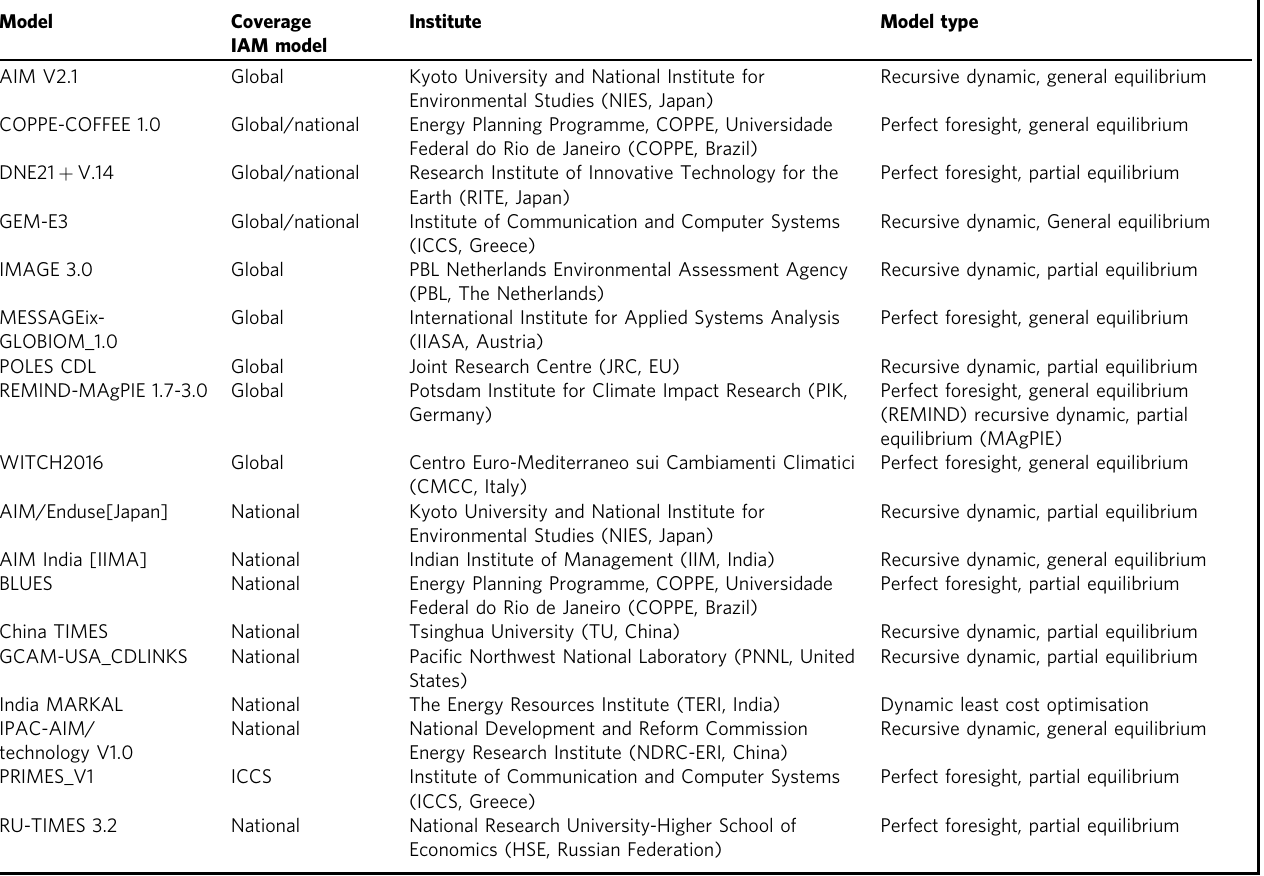
Table 4 Participating integrated assessment models in the model exercise to assess the impact of climate policies.